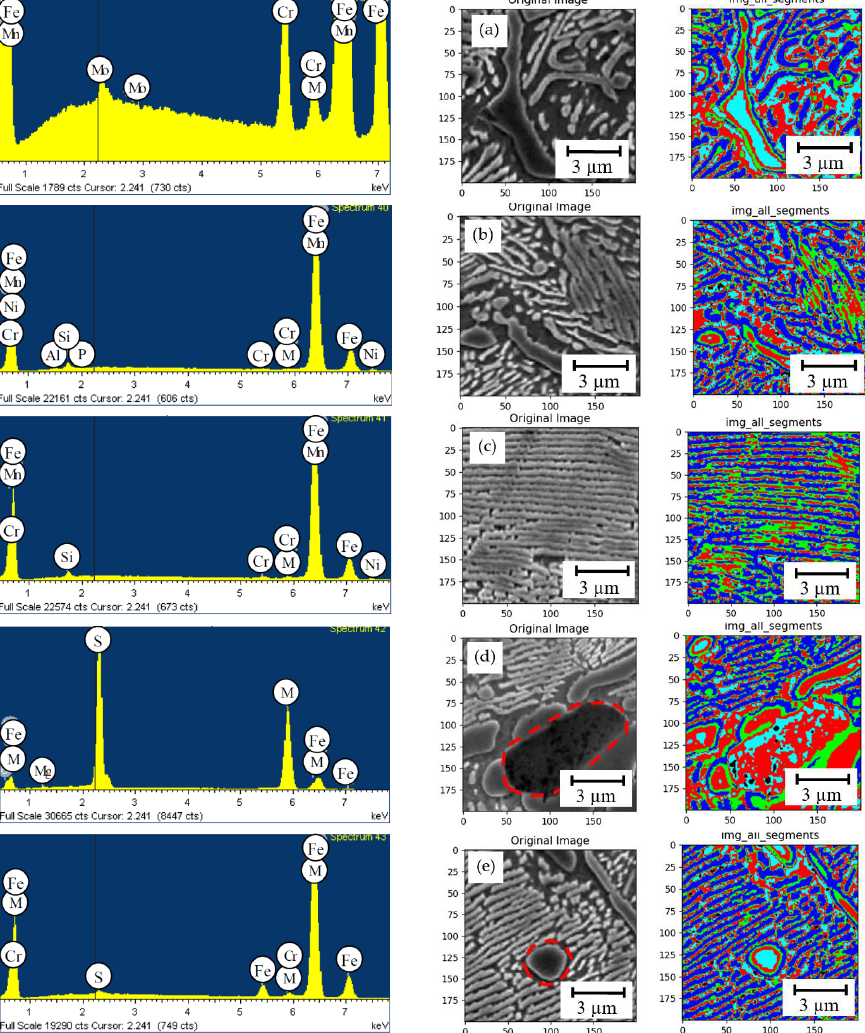
Figure 4. The components’ distribution according to the structural components of the hypereutectoid steel with 1.8% C at the as-cast state. ( a )—cementite, which is a part of the carbide mesh; ( b )— depleted area next to the cementite mesh; ( c )—perlite; ( d )—manganese sulfide next to the graphite inclusion; ( e )—isolated cementite inclusion.